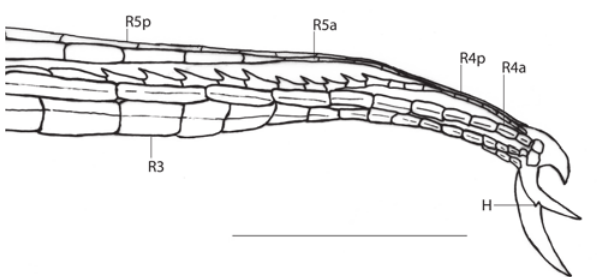
Fig. 43. Gonopodium tip of Phalloceros buckupi , MCP 31190. R3, R4a, R4p, R5a, R5p indicate gonopodial rays. Scale bar 1